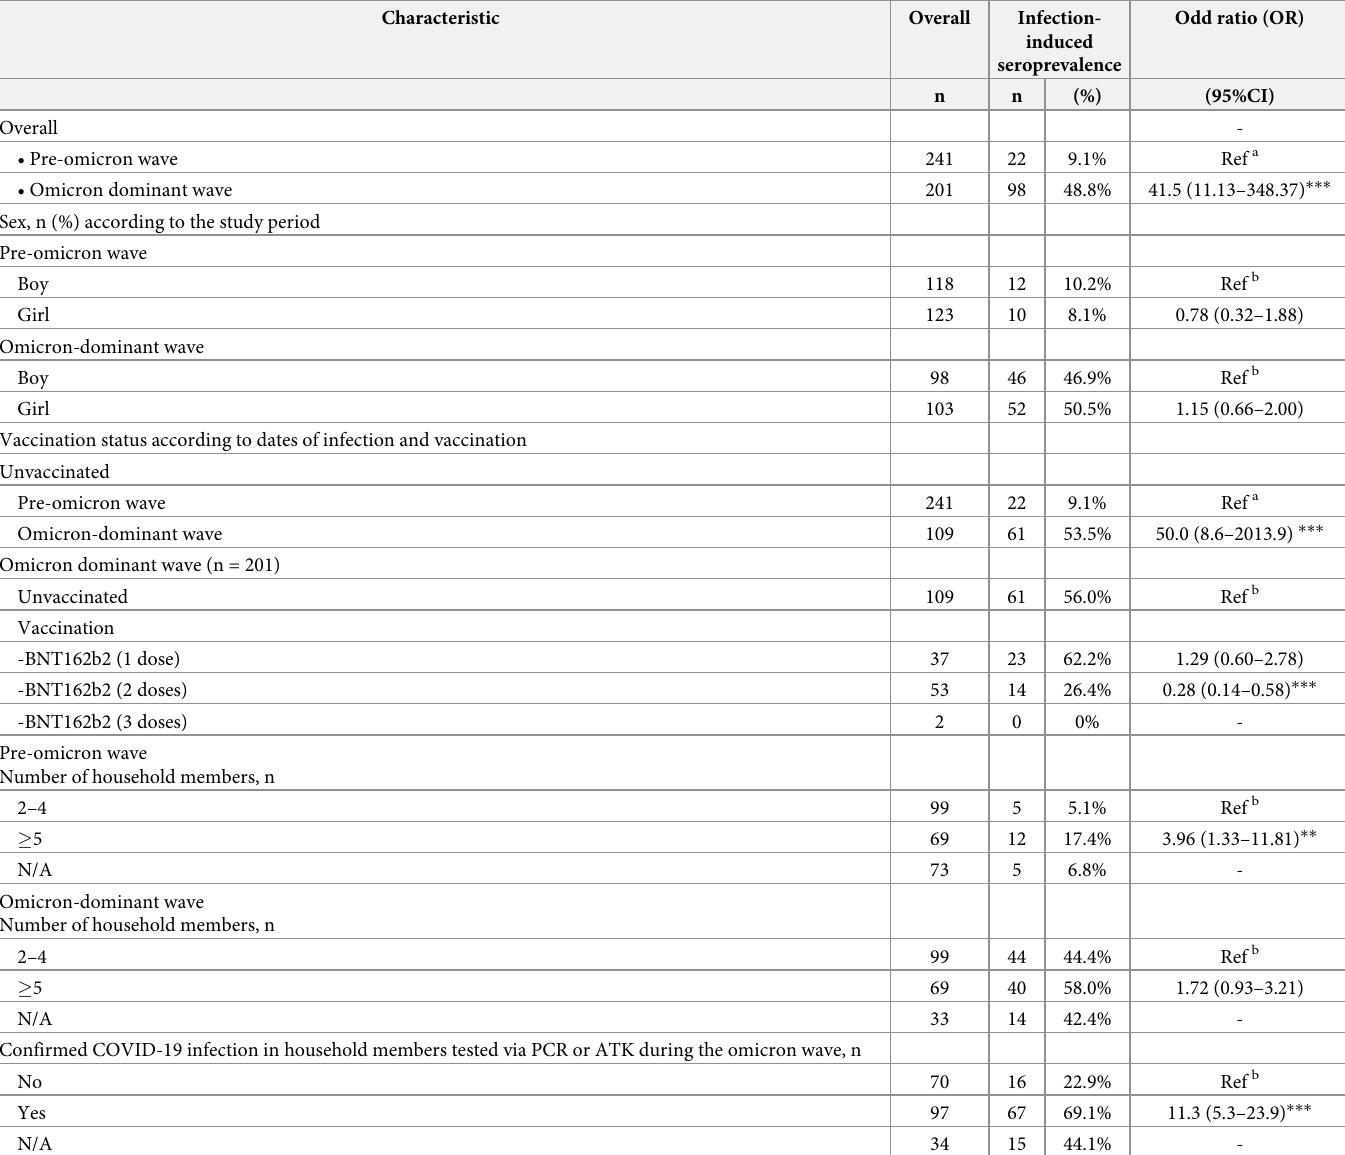
Table 1. SARS-CoV-2 infection-induced seropositivity and associated potential risk factors.